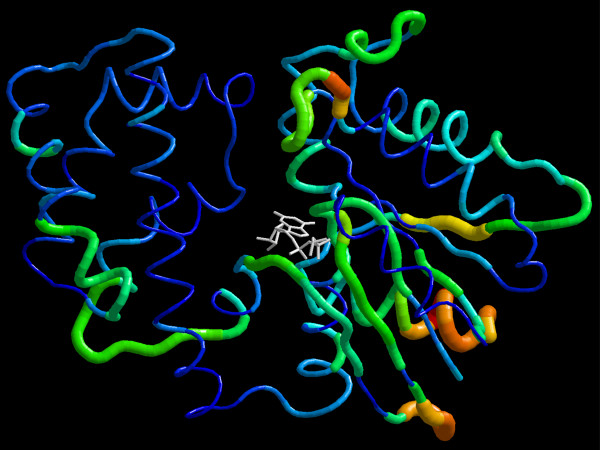
Changes in local folding free energy upon "nucleotide exchange" on Gαi. Changes in free energies upon nucleotide exchange in Gαi are calculated from data given in figure 3 and mapped onto the structure of Gαi1-GTPγS (PDB ID: 1GIA). Changes are shown on the color-coded trace-tube representation of the molecule (blue: no change – red: maximum change ~6 kcal/mol). Trace-tube radius changes proportionally to the magnitude of free energy change to help visual perception. RasTop program v2.0.3 (Philippe Valadon, 2003) is used for 3D visualization.